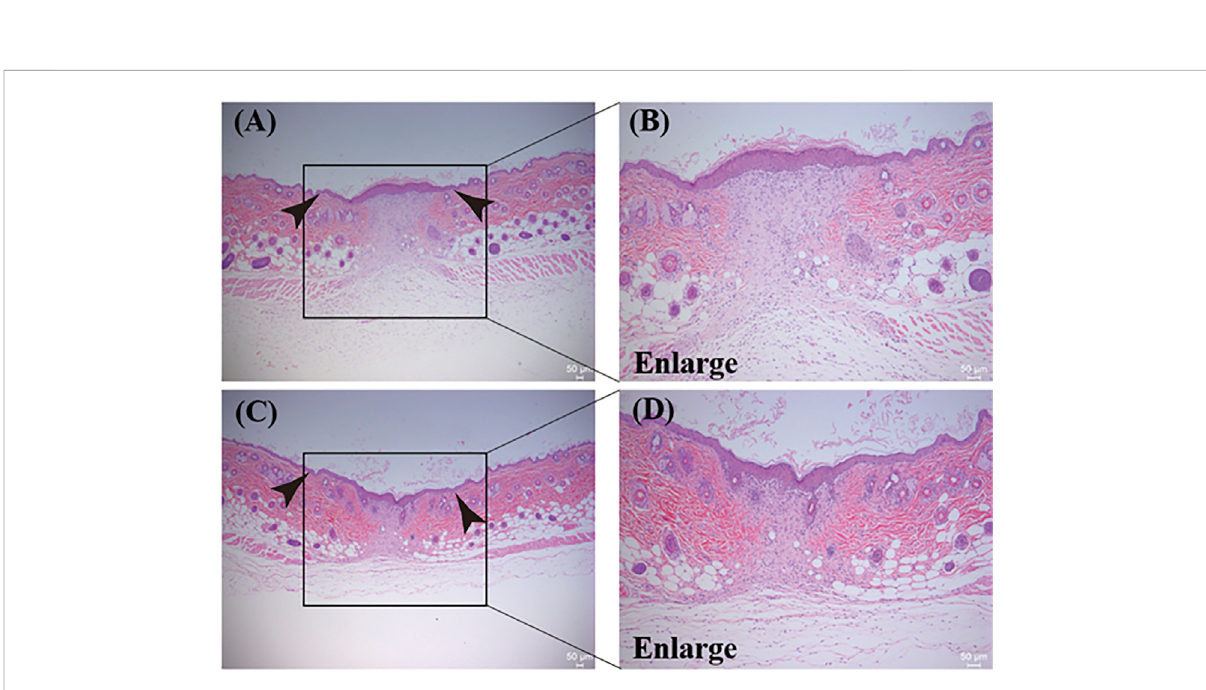
FIGURE 8 H&E staining results of mouse dorsal skin tissue protected by (A) PBS and (C) the water-based PEG/CS composite lubricant. (B) and (D) are magni fi ed images of the corresponding boxed areas.